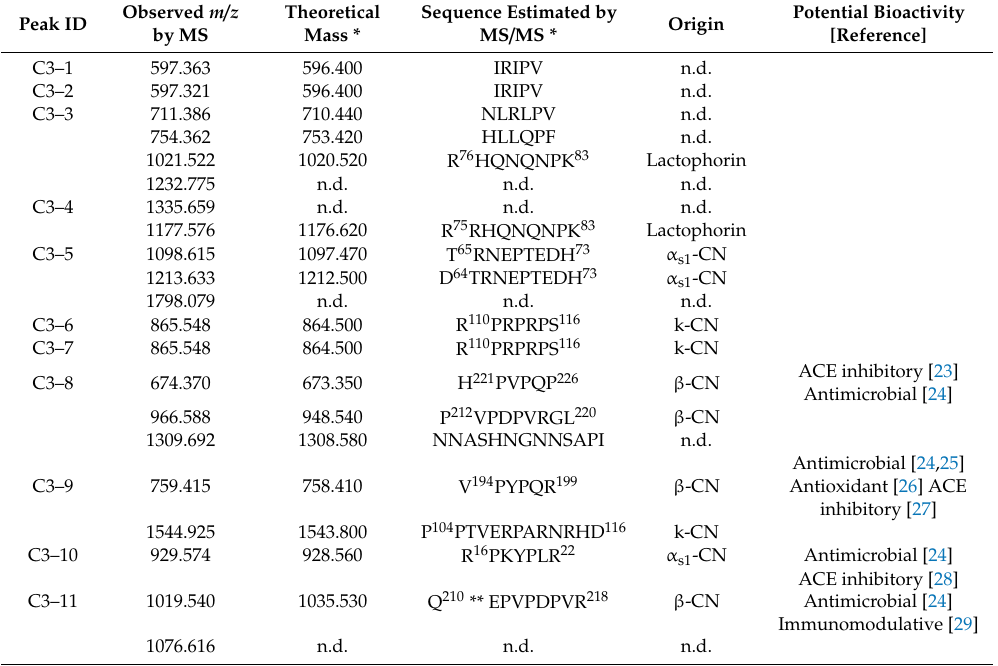
Table 1. Identified peptides in the fermented camel’s milk